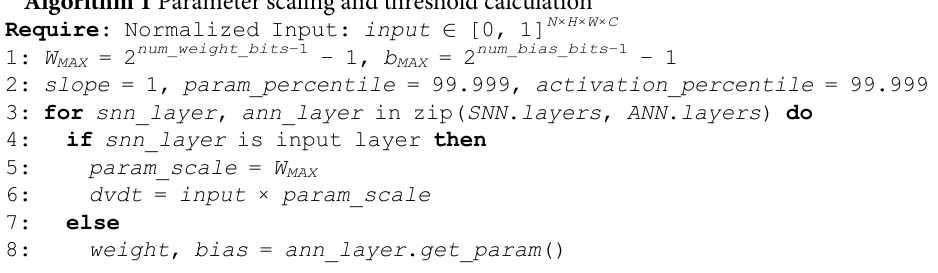
Algorithm 1 Parameter scaling and threshold